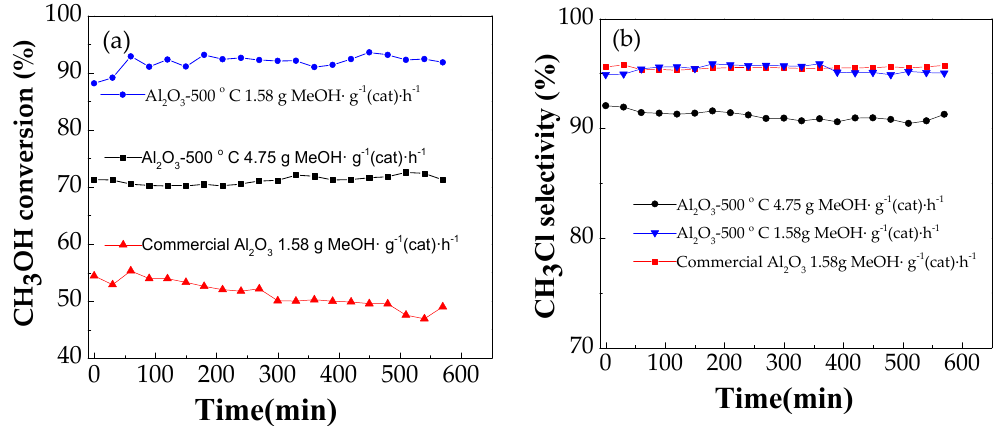
Figure 4. The methanol conversion ( a ) and the methyl chloride selectivity ( b ) over commercial alumina and mesoporous alumina (Conditions: temperature 280 °C).